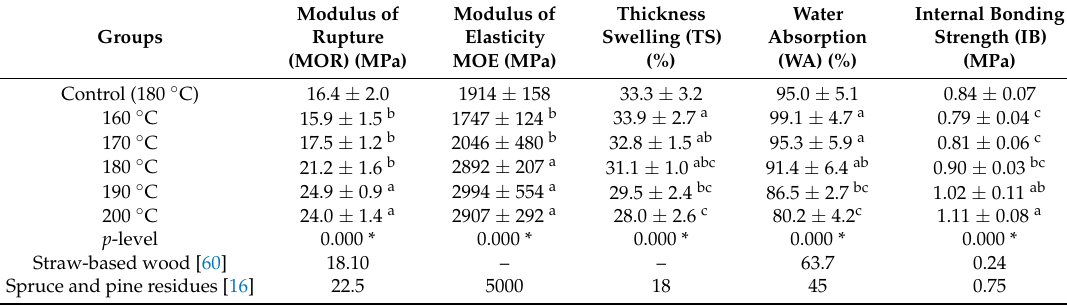
Table 4. The mean values and standard deviations of physical-technological properties, obtained using one-way analysis of variance (ANOVA) and Tukey’s test